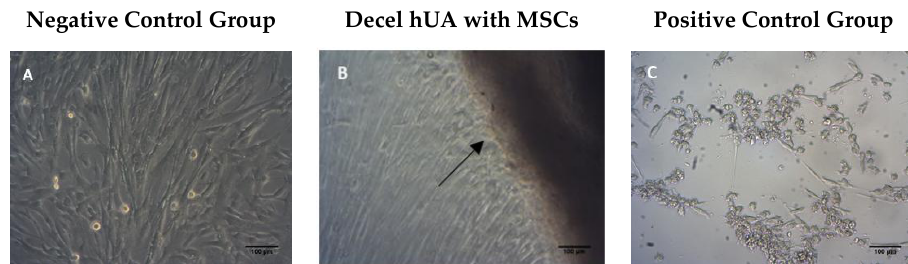
Figure 2. Contact cytotoxicity assay. ( A ) MSCs cultured under normal conditions (negative control group); ( B ) MSCs were co-cultured with decellularized hUA, ( C ) MSCs with SDS (positive control group). Black arrows indicate the contact of MSCs with the segments of decellularized hUA. Original magnification 10×, scale bars 100 μm.